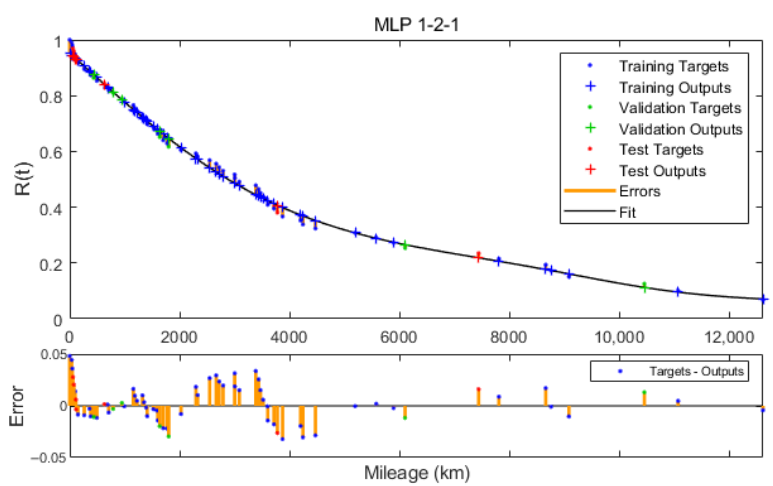
Figure A1. Reliability function approximated by MLP 1-2-1.